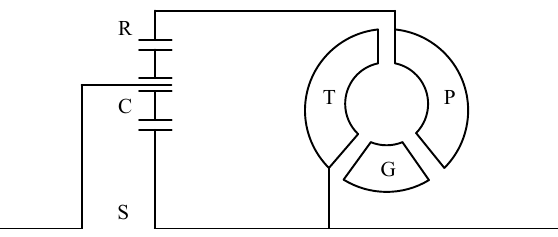
Figure 14. Architecture of solution c .